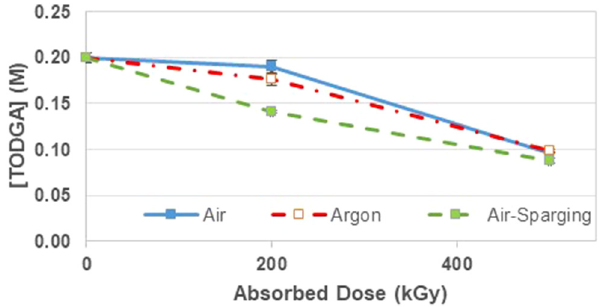
Fig. 2. Concentration of TODGA as function of the dose for 0.2mol/L TODGA irradiated in contact 0.5 mol/L HNO 3